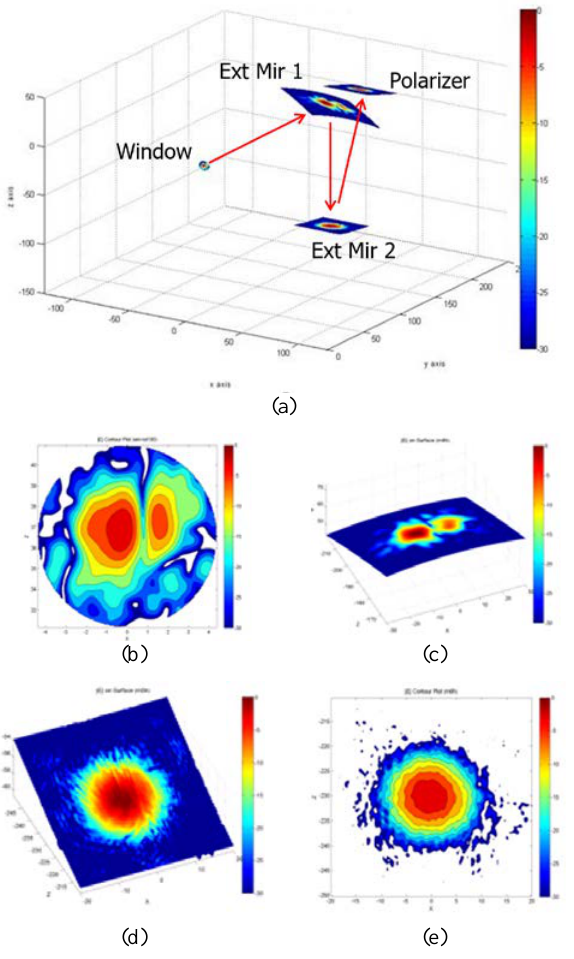
Fig. 4. External phase correction of 176 GHz radiation pattern using numerically synthesized mirror surfaces improves Gaussian beam coupling from 24% to 98%. Shown above: (a) Simulation geometry; (b) Field pattern at output window; (c) Field pattern at external mirror 1; (d) Field pattern at external mirror 2; (e) Field pattern at polarizer